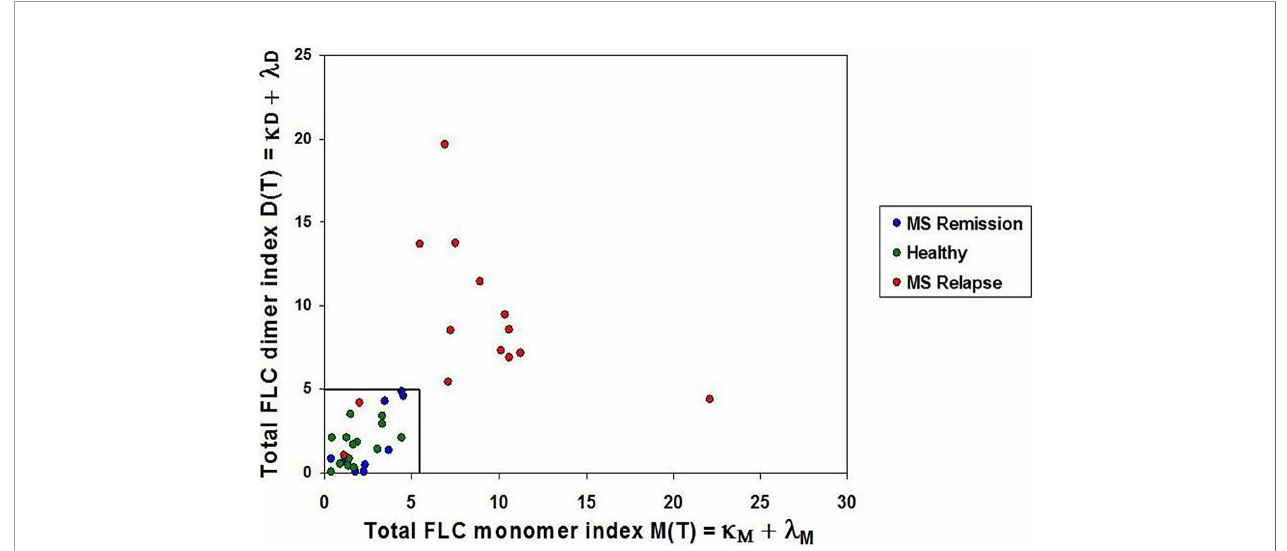
FIGURE 2 | Saliva FLC indices in naive POMS patients. POMS patients in relapse - red circles; POMS patients in remission - blue circles; healthy children - green circles. Most of the POMS patients in relapse demonstrate the abnormally high values of the FLC indices. (D(T) > 5.0 and/or M(T) > 5.5) as compared to the healthy individuals and the POMS patients in